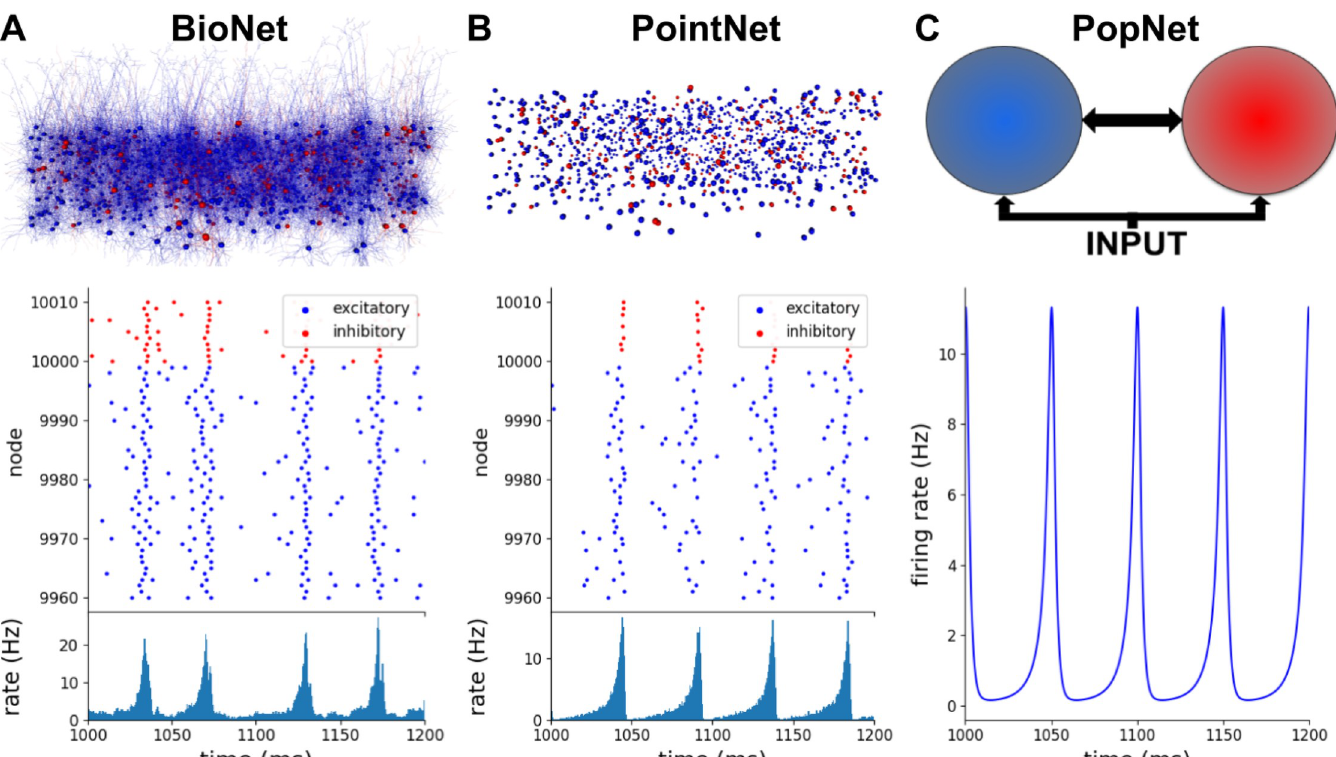
Fig 4. Biophysically detailed, point-neuron, and population simulations with BioNet, PointNet, and PopNet. In all three cases, the interconnected populations of excitatory and inhibitory neurons receive excitatory input from an external population (1,000 Poisson sources firing at the frequency of 150 Hz, replaced by a uniform population in the PopNet case). (A) Biophysically detailed network of randomly connected excitatory and inhibitory neurons, 12,500 total. An RTNeuron visualization of the network is shown alongside its spiking output (spikes from a small portion of the network are shown, for clarity) and the firing rate (for the whole excitatory population) produced by the BMTK’s BioNet module. (B) The same network using the point-neuron approximation. An RTNeuron visualization and simulation output from the BMTK’s PointNet module simulation are shown. (C) Population-based representation of the same network. A schematic of the model and the output of population-density simulation (firing rate for the excitatory population is shown) from BMTK’s PopNet module are illustrated.